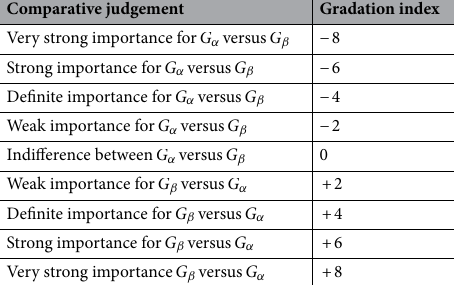
Table 3. Integer-valued cluster important judgement designating the gradations made by decision makers.